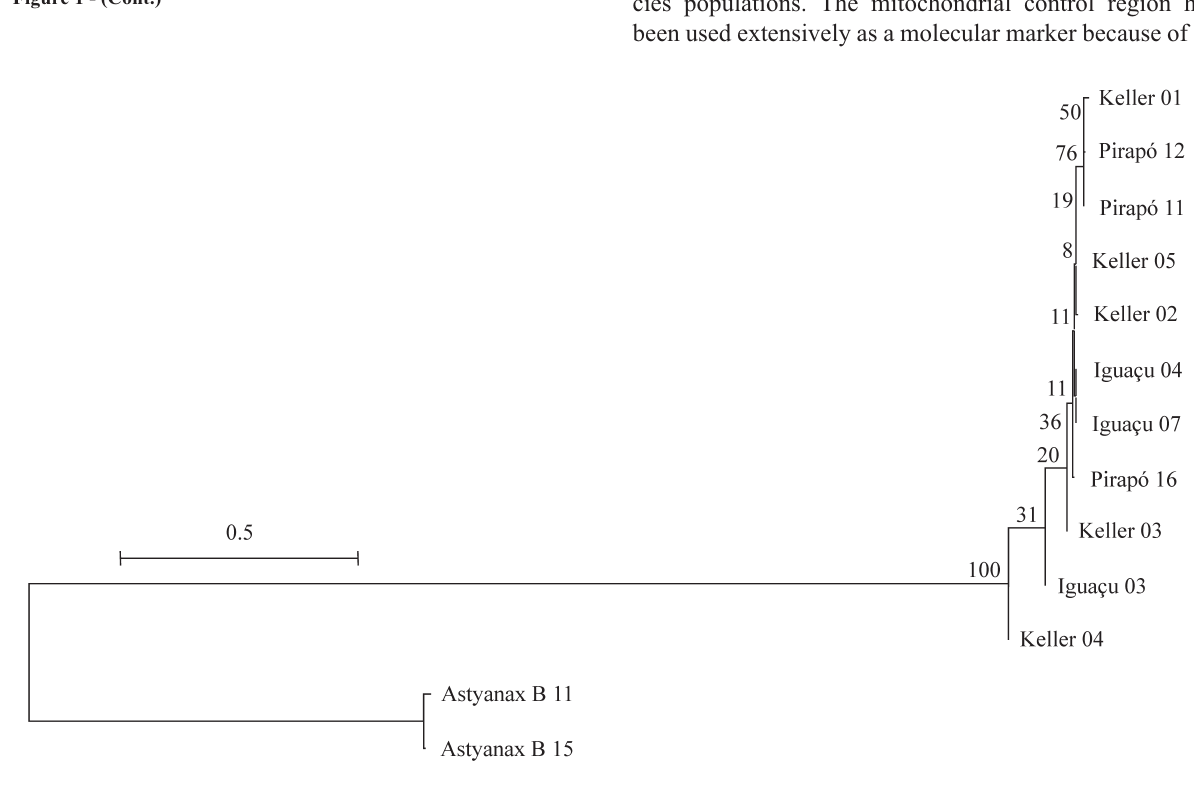
Figure 2 - Neighbor-joining tree for mitochondrial control region sequences of Astyanax altiparanae specimens from the Iguaçu River and from the Keller and Pirapó tributaries of the Upper Paraná River basin. Genetic distance was computed by using the Tamura and Nei (1993) method. The tree is rooted to the closely related species Astyanax sp B. Number on each node indicates bootstrap probability based on 1000